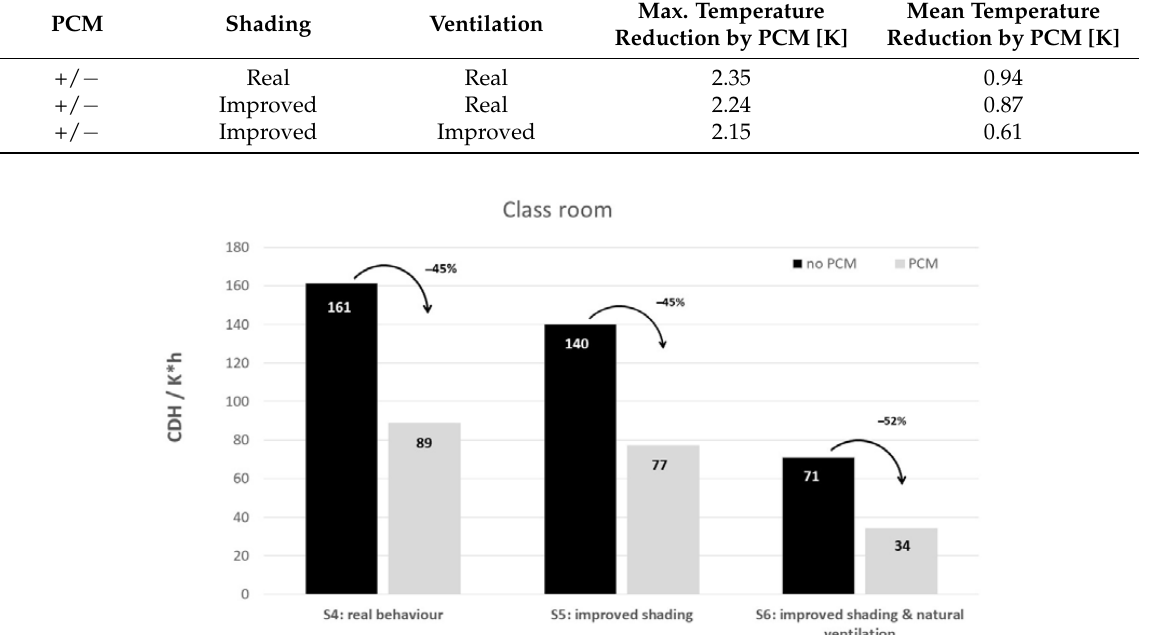
Table 4. Simulation results of different behavioural scenarios and influence of PCM for the classroom from June through September. Temperature reductions indicated are due to PCM scenario (+) compared to scenario without PCM ( − ), respectively.